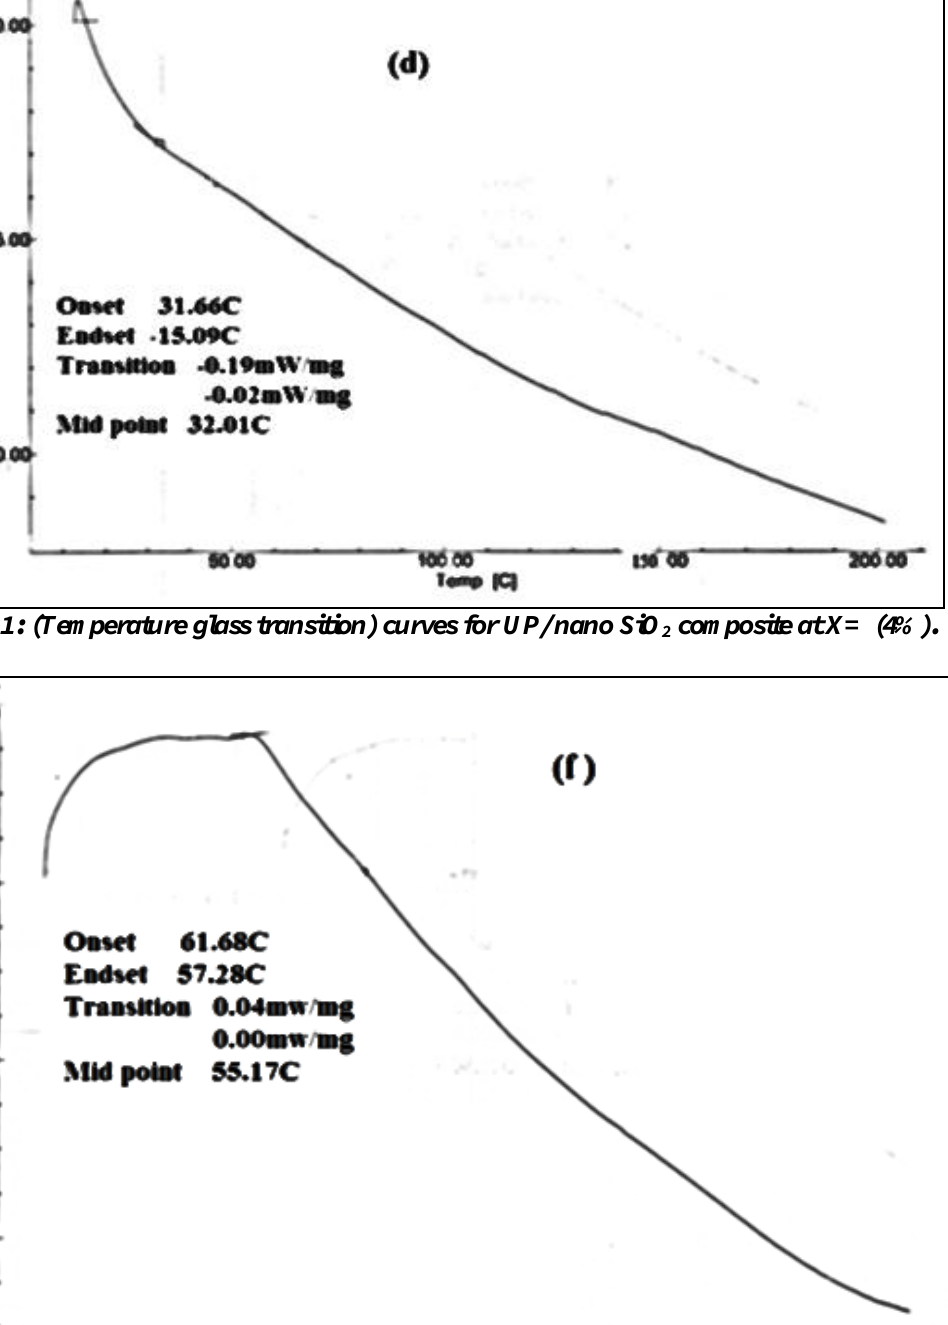
composite at X= 2